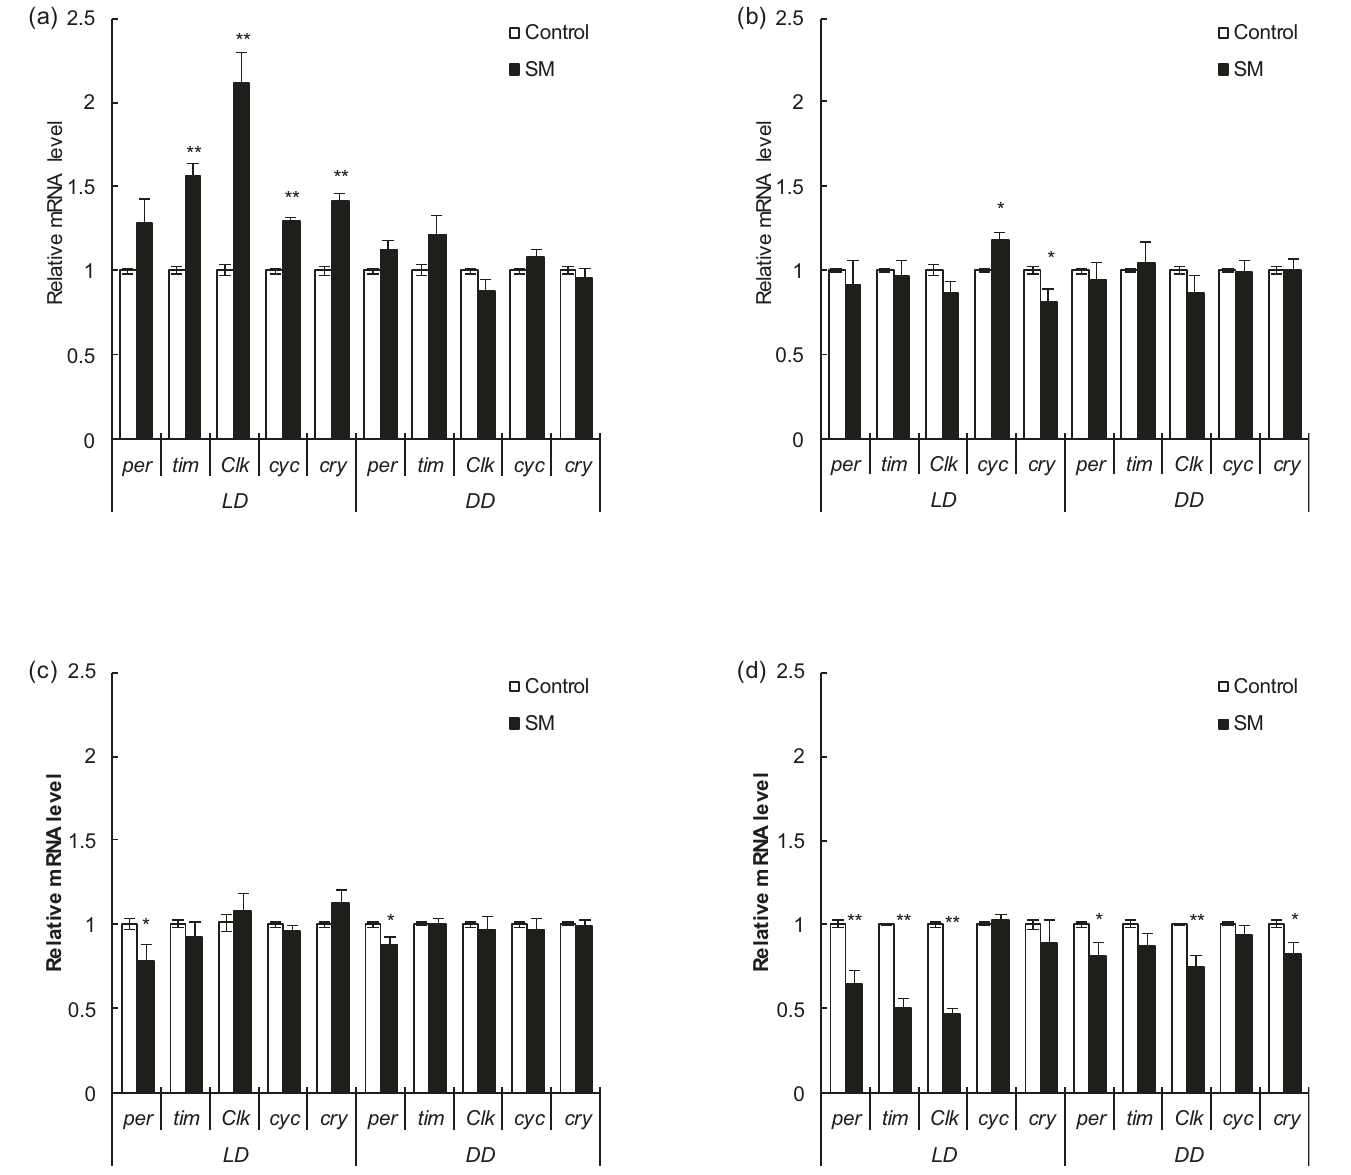
Fig. 4 Relative expression levels of target major clock genes after 3 days of simulated microgravity under LD and DD conditions. a Canton-S males. b Canton-S females. c w1118 males. d w1118 females. White and black boxes represent data for the control and simulated microgravity fruit fl ies, respectively. * P < 0.05, ** P < 0.01. Error bars represent standard